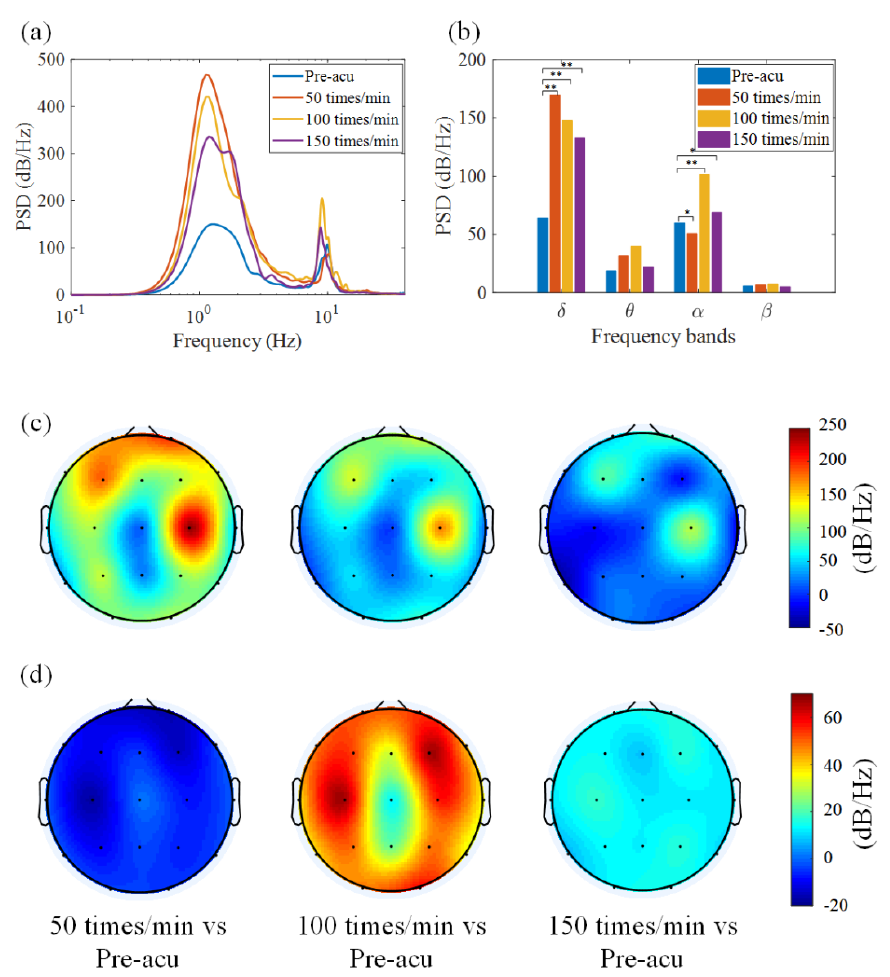
Figure 3. Brain activity associated with manual acupuncture stimulation. ( a ) Power spectrum char- acteristics of EEG data under different states. ( b ) PSD distribution in different frequency bands. p < 0.05 (*) and p < 0.01 (**) represent significant difference levels between pre-acupuncture and acu-puncture states. ( c , d ) Topographic map showing the variance of the PSD distribution between ac-tivity during and before different acupuncture manipulation states in ( c ) delta and ( d ) alpha fre-quency bands. Acupuncture can significantly affect the oscillatory activity in the delta and alpha frequency bands within EEGs. This variance is increased in the frontal and parietal lobes.